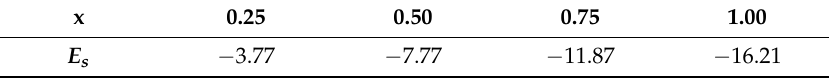
Table 1. Substitution Energies (in eV) of the Ge x Sn 1-x Se Alloys with Different Ge Contents.